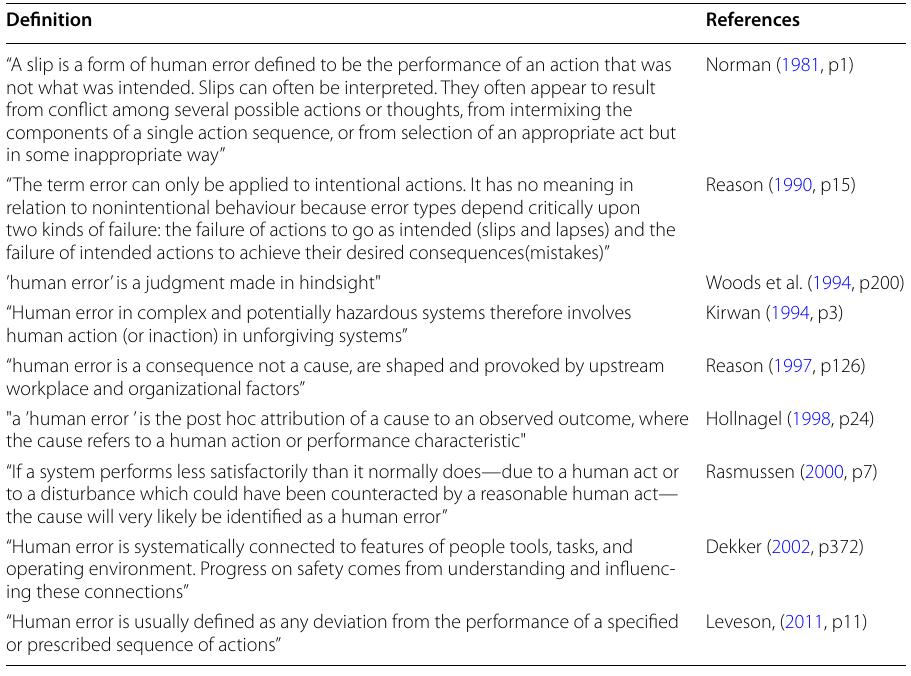
Table 1 Definitions of human error (HE)